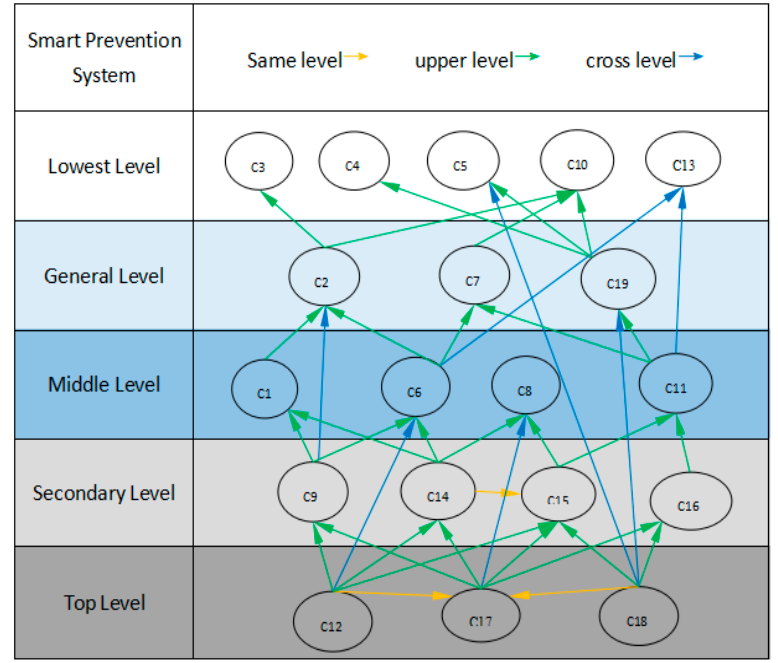
Figure 3. Interpretive structural modeling ( ISM) model structure diagram of influencing factors.